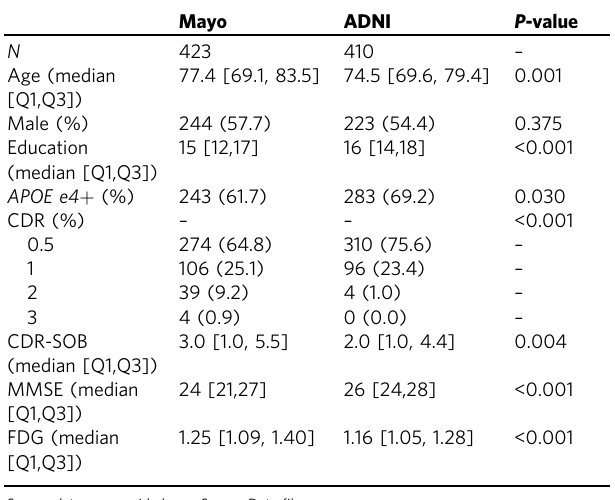
Table 1 Mayo and Alzheimer ’ s disease neuroimaging initiative sample